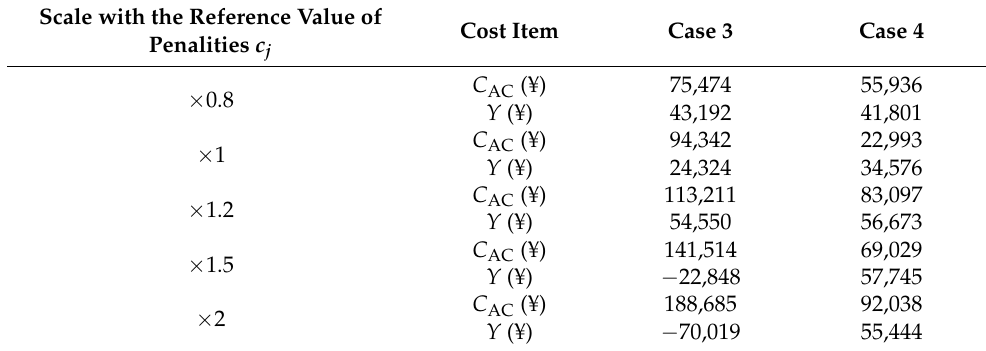
Table 6. Performance under different penalties of violating contract items.